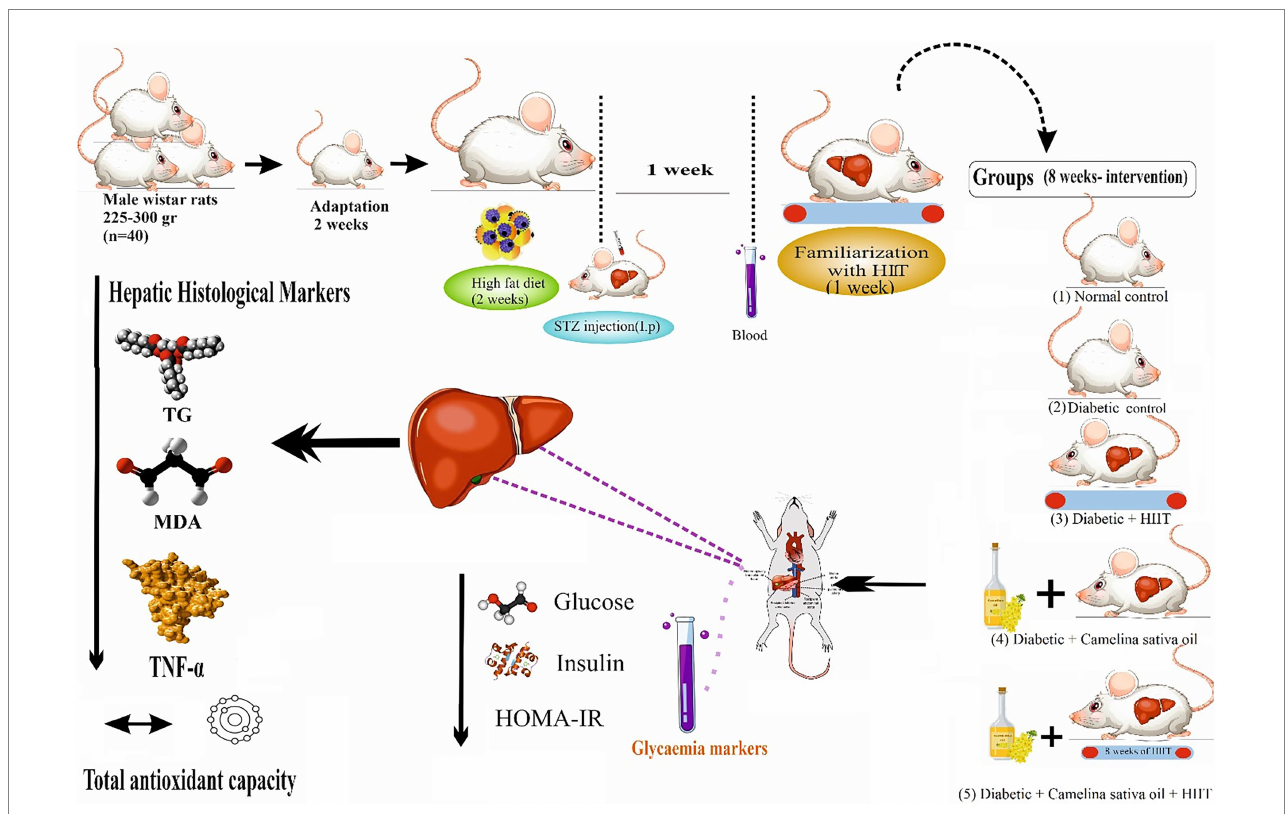
FIGURE 1 Experimental design. HIIT, High-intensity interval training.